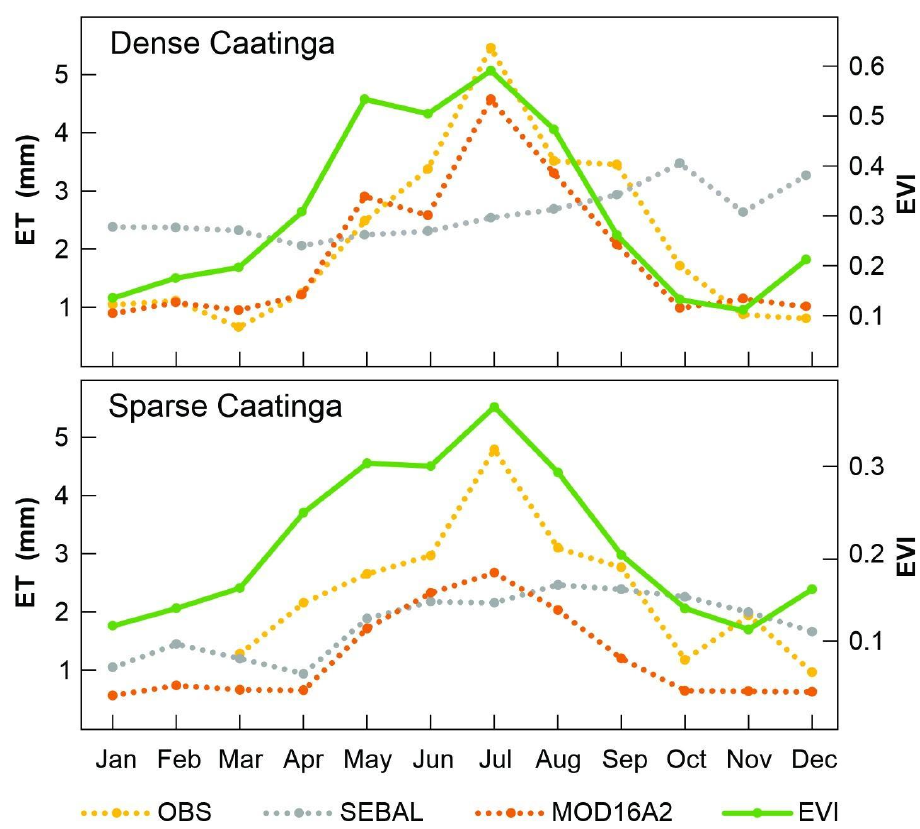
Figure 2. Monthly temporal distribution of ET in the areas of DC and SC in 2013.